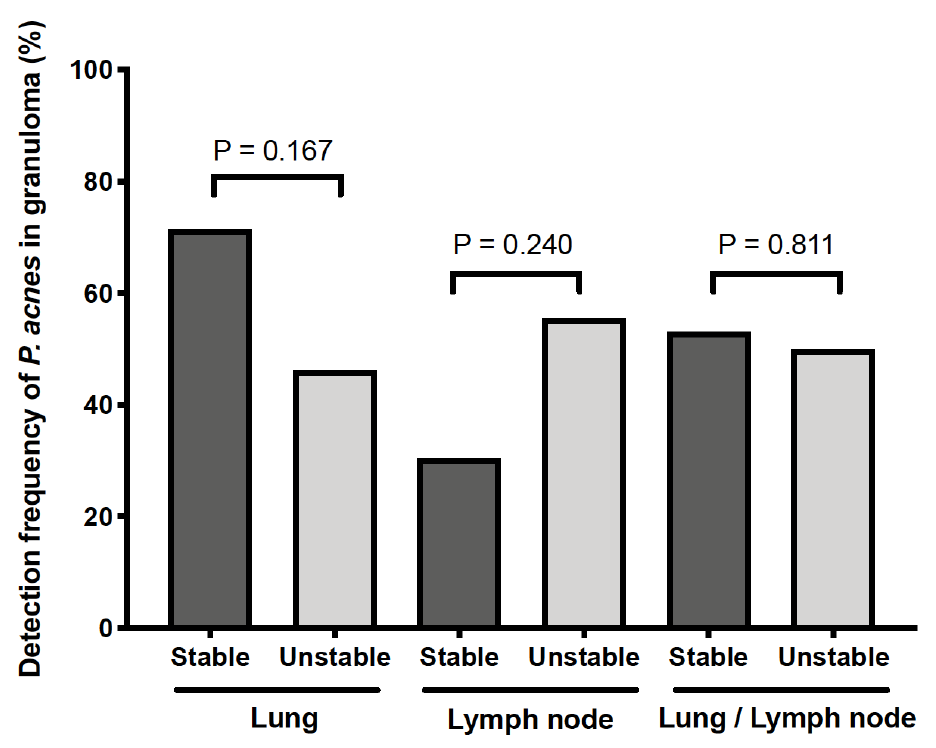
Figure 3. No association between the clinical outcome of sarcoidosis and the detection status of P. acnes in granulomas. Sarcoidosis patients were divided into stable and unstable groups ( n = 49 and 22, respectively) as described in the Materials and Methods. Detection frequency (%) of P. acnes in granulomas was compared between the two groups of patients according to the organ used for the evaluation by immunohistochemistry: the lung ( n = 41), lymph node ( n = 32), and either lung or lymph node ( n = 71). No significant difference was observed between the stable and unstable groups, regardless of the organ used for the evaluation of P. acnes in granulomas. Finally, 46 sarcoid tissue samples with P. acnes detected in granulomas by manual